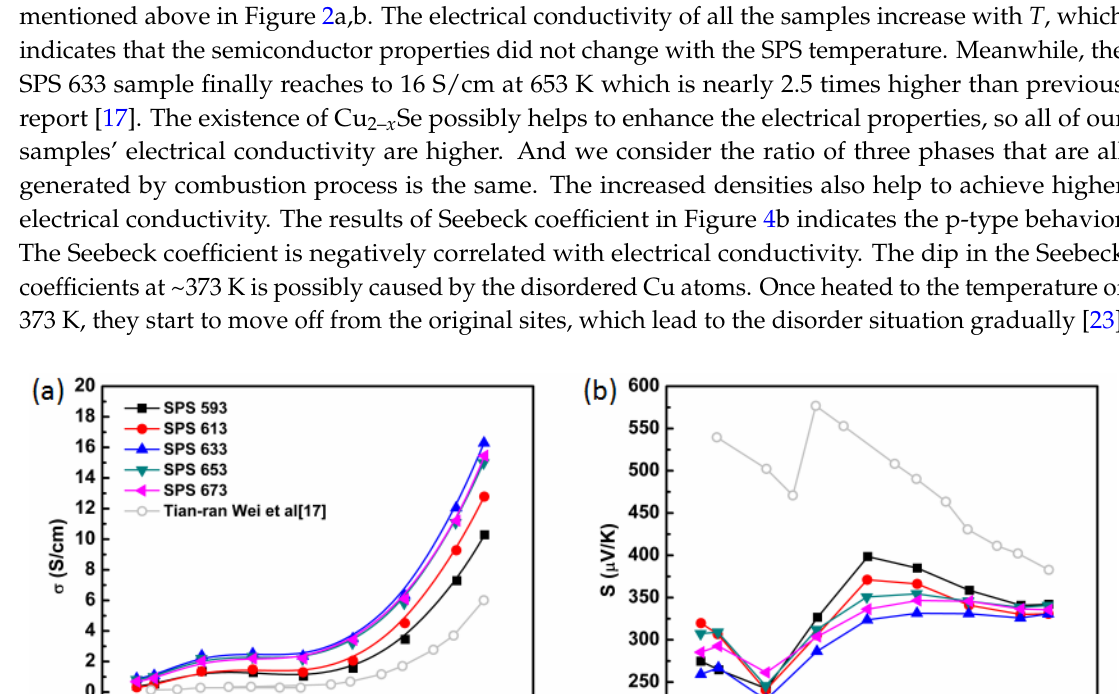
Figure 3. Relative density of all the bulk samples.